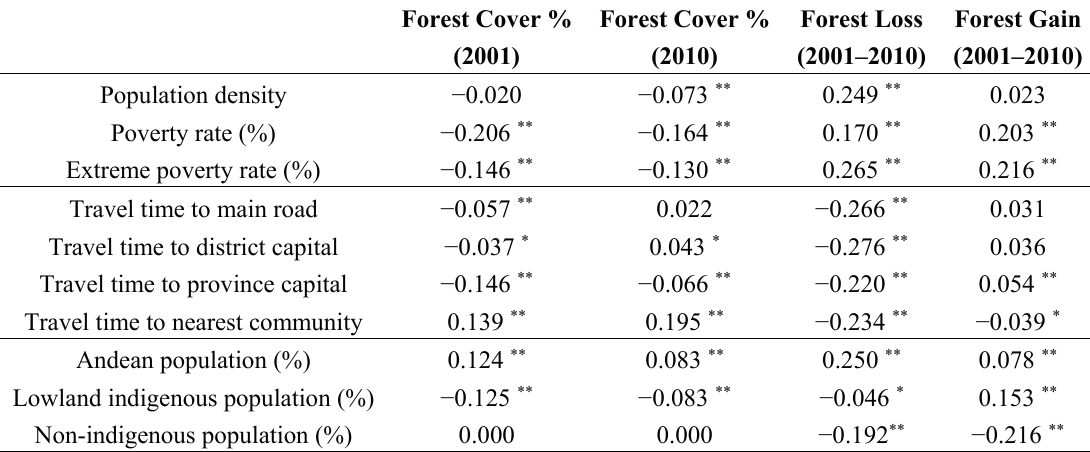
Figure 4. Forest cover change rate in relation with socio-economic variables in the North of La Paz forest landscape (NLP). Table 4. Pearson correlations between forest cover change and socio-economic variables in the North of La Paz forest